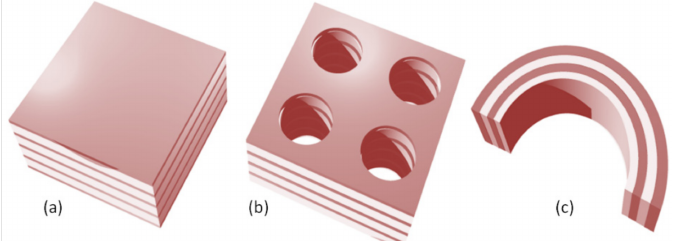
Figure 10. Some examples of hyperbolic metasurfaces. ( a ) simple metal-dielectric multilayer; ( b ) multilayer plasmonic fishnet; ( c ) sculpted metal-dielectric multilayer (can perform a function of a cylindrical hyperlens).